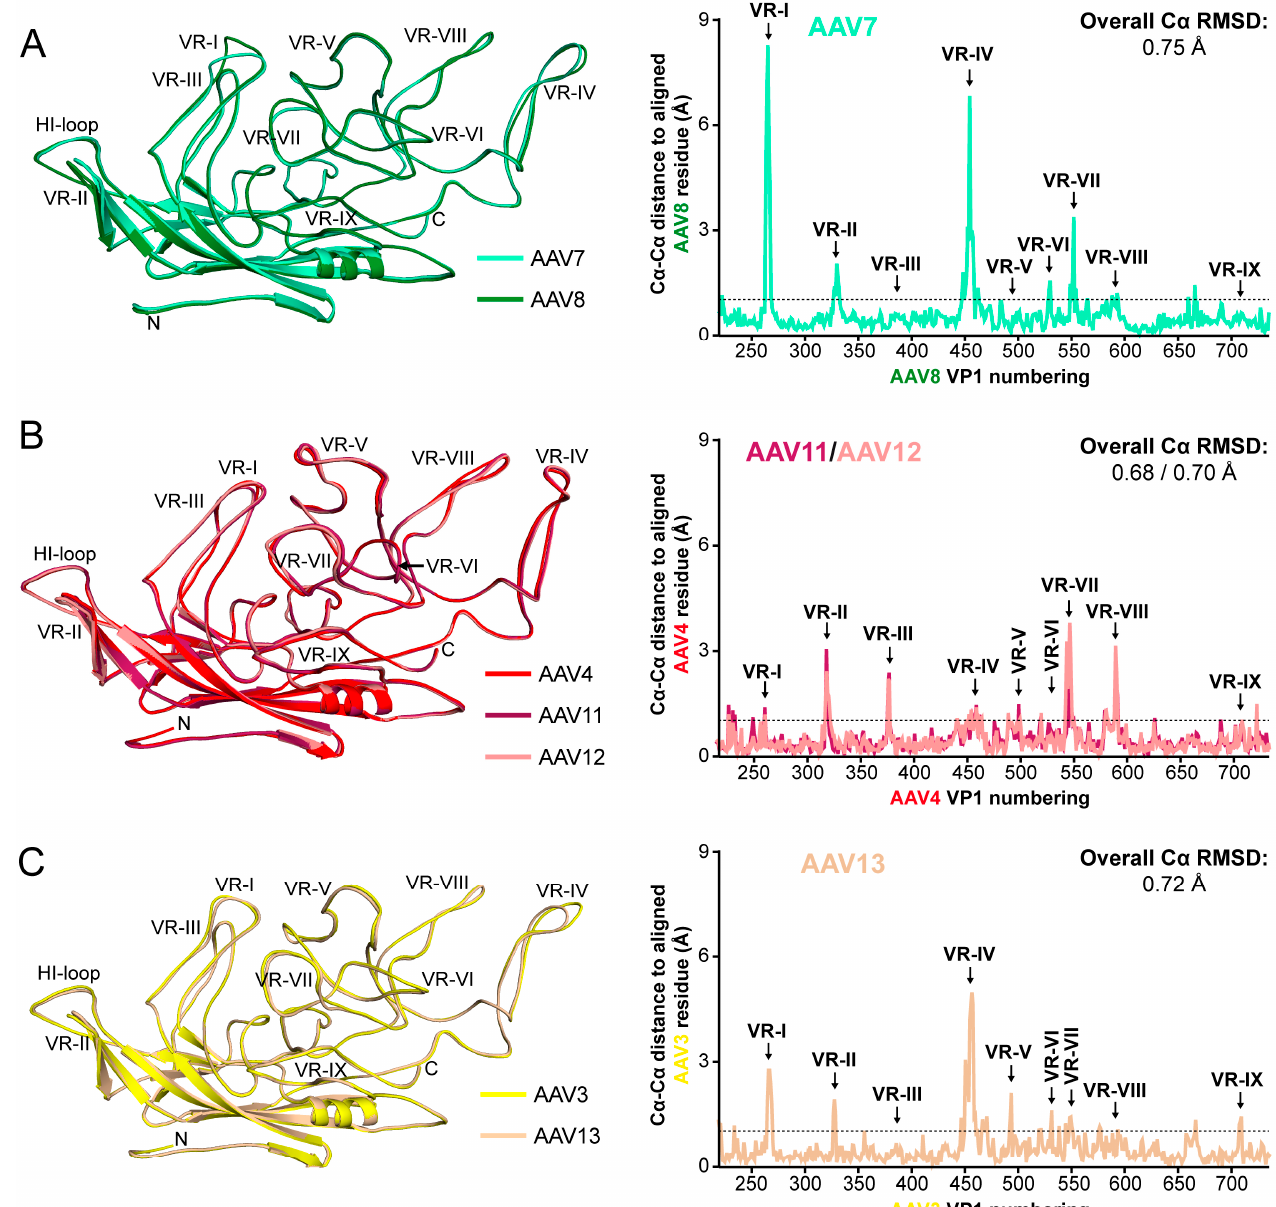
Figure 6. Structural comparison of AAV7 and AAV11–13 to their closest clade member. ( A ) Left—Structural superposition of AAV7 (cyan) and AAV8 (green) shown as ribbon diagrams. The positions of the N- and C-terminus and the variable regions (VRs) are indicated. This figure was generated using PyMol [60]. Right—C α –C α distance plot (in Å) for the AAV7 residues relative to AAV8 when the VP structures are superposed. The VRs are indicated, and the overall AAV7 VP C α –RMSD compared to AAV8 is shown. The dashed line marks a C α –C α distance of 1 Å. ( B ) Structural comparison as in (A) for AAV4 (red), AAV11 (burgundy), and AAV12 (salmon). ( C ) Structural comparison as in (A) for AAV3 (yellow) and AAV13